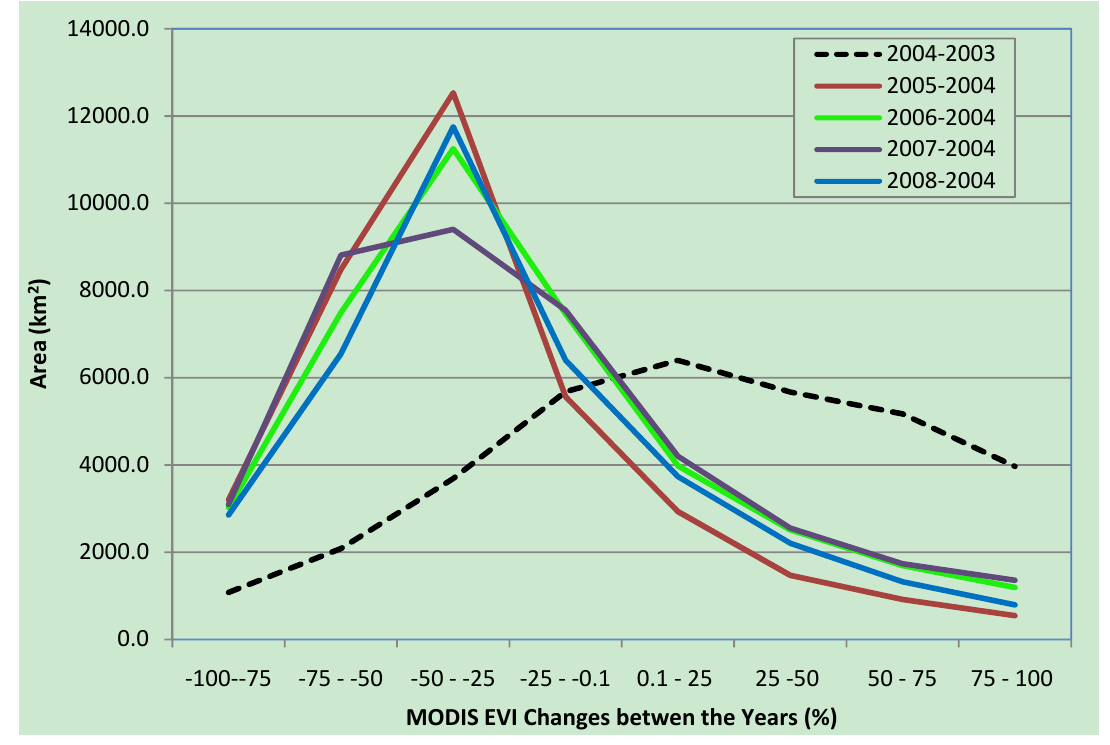
Figure 8. Area of vegetation by category of MODIS EVI changes between the